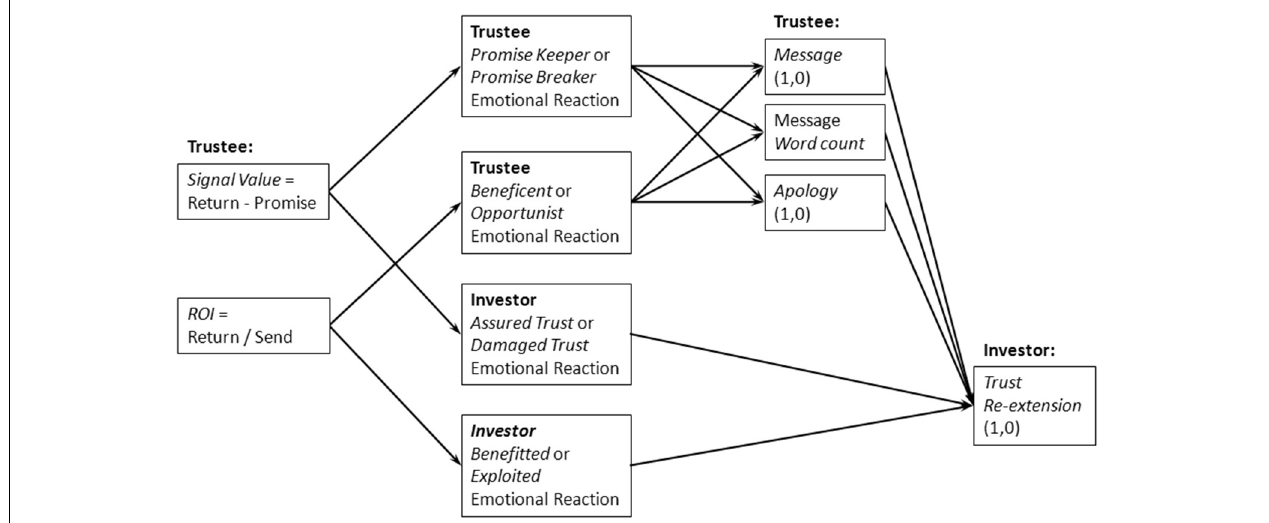
FIGURE 1 | Path model of predicted relationship between